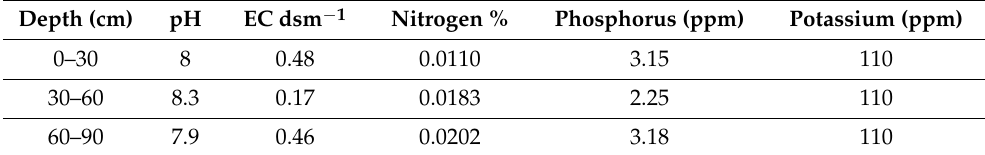
Table 4. Chemical Analysis of Soil